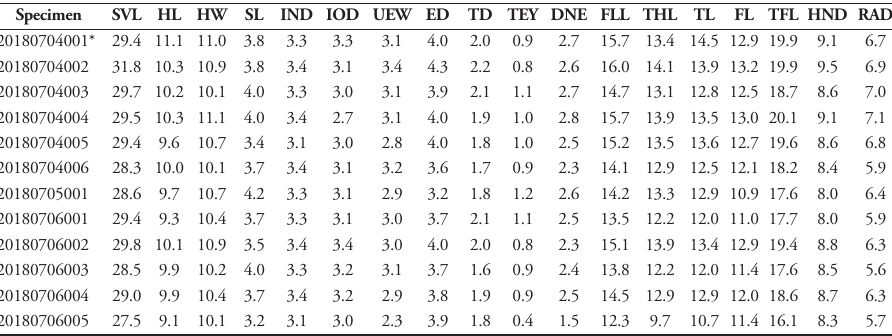
Table 8. Variation in morphological measurements amongst the holotype* and paratypes. Each character was measured three times, the values in the table represent the average of the three measurements. *De- notes